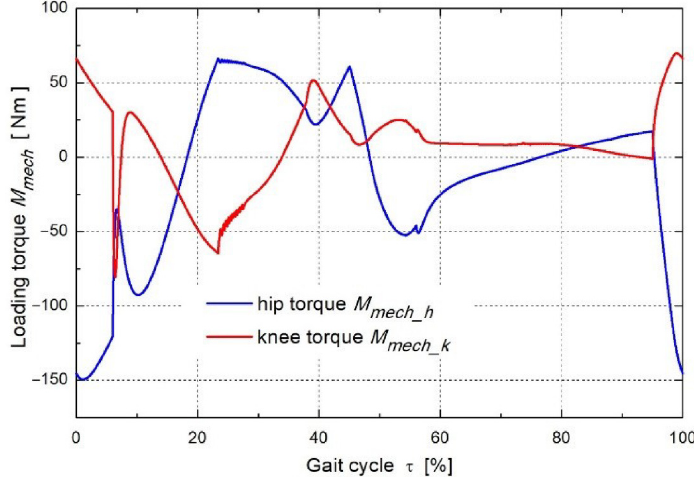
Figure 12. The load torque courses at the driven joints for step length of l = 0.4